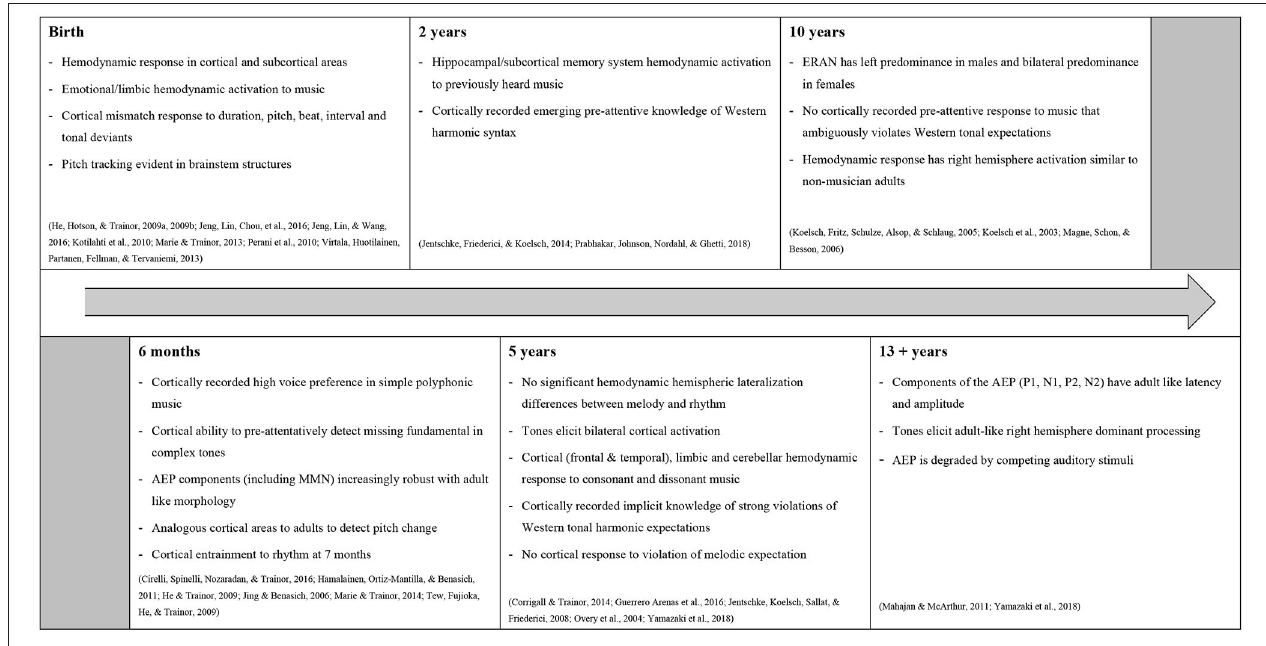
FIGURE 2 | Timeline of significant developments of musical